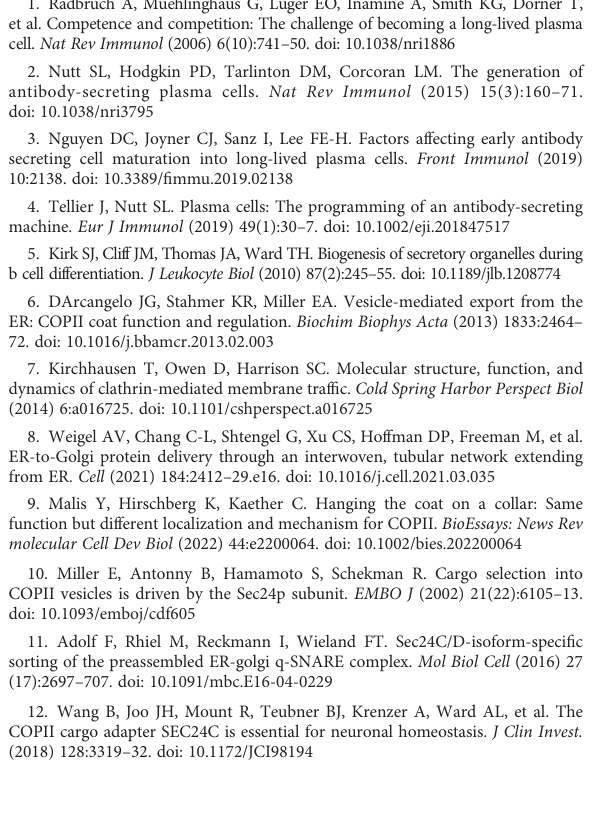
SUPPLEMENTARY TABLE 1 RNA-seq analysis using DEseq and rMATS. DEseq gene counts ar displayed for each sample and each detected gene. RMATS quanti fi cation shows the signi fi cant splicing events. Gene name, the coordinates of the splice event, the type of splice event (SE: skipped exon, RI: intron retention, A5SS: alternative 5 splice site, A3SS: alternative 3 splice site) and the PSI for every sample. SUPPLEMENTARY TABLE 2 Correlation analysis of PC upregulated COPII vesicle coat budding genes in human tissues. For every gene the pearson R and the p-value of correlation for all nine genes upregulated in PC in the GO term COPII- coated vesicle budding are displayed. SUPPLEMENTARY TABLE 3 Transcription factor binding motifs enriched in the promoter of all genes upregulated in PCs. The analysis was performed with ShinyGO 0.76 tool using a list of 2746 genes upregulated in PCs when compared to MBCs. ShinyGO retrieves enriched TF binding motifs, transcript annotation, and promoter sequences from Ensembl. This tool recorded the best score for each of the TFs in every 300bp and 600bp promoter sequence. Students t- test isused to comparethe scores observed in a group ofgenes against the rest ofthe genes. The P -valuesarecorrected